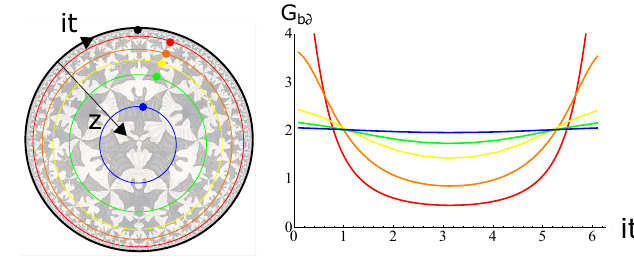
Figure 9 . Euclidean bulk-to-boundary two point function at finite temperature ( C = 1 / 2), with the bulk point at ( it, z ), as a function of ∆ t . Red: z = 0 . 5, Orange: z = 1, Yellow: z = 2, Green: z = 3, Blue: z =